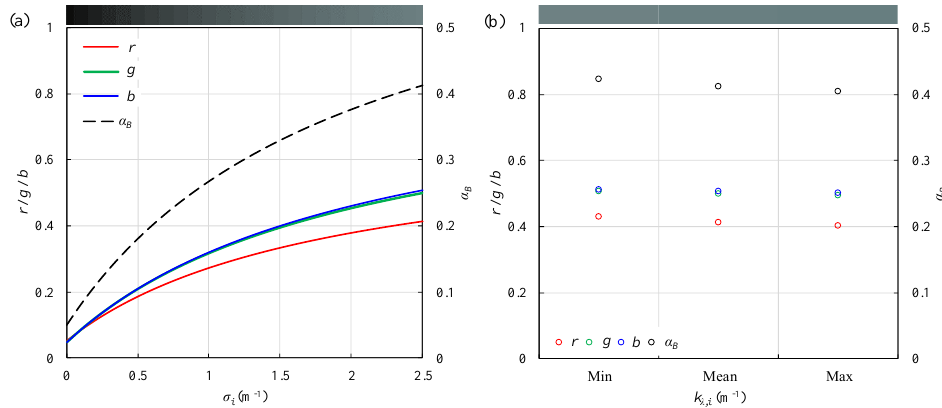
Figure 7. Variation of the RGB intensities of pond color and melt-pond albedo with the inherent optical properties of underlying sea ice: (a) scattering coefficient and (b) absorption coefficient for H p = 0.3m and H i = 1.0m. Note that σ i within 1.2–2.5m − 1 is valid for sea ice under melt ponds, and σ i = 0 is presented only as a comparison as an idealized purely absorbing medium. The color bar on top denotes the simulated color of the melt pond under different optical properties of sea ice.